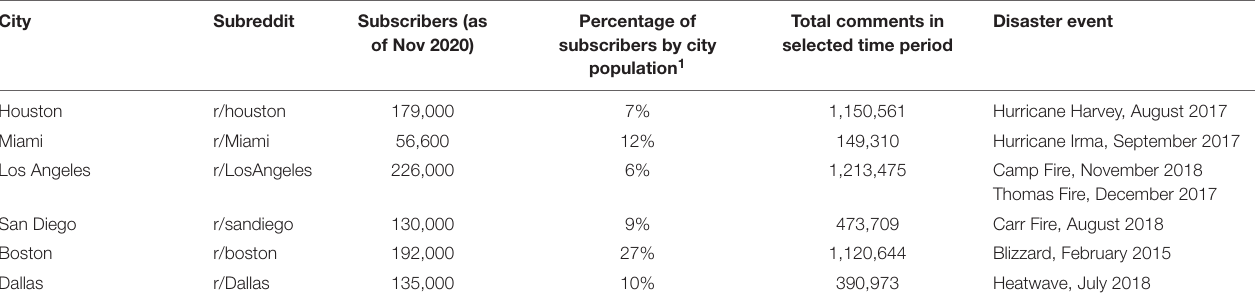
TABLE 1 | Details of city subreddits and related natural